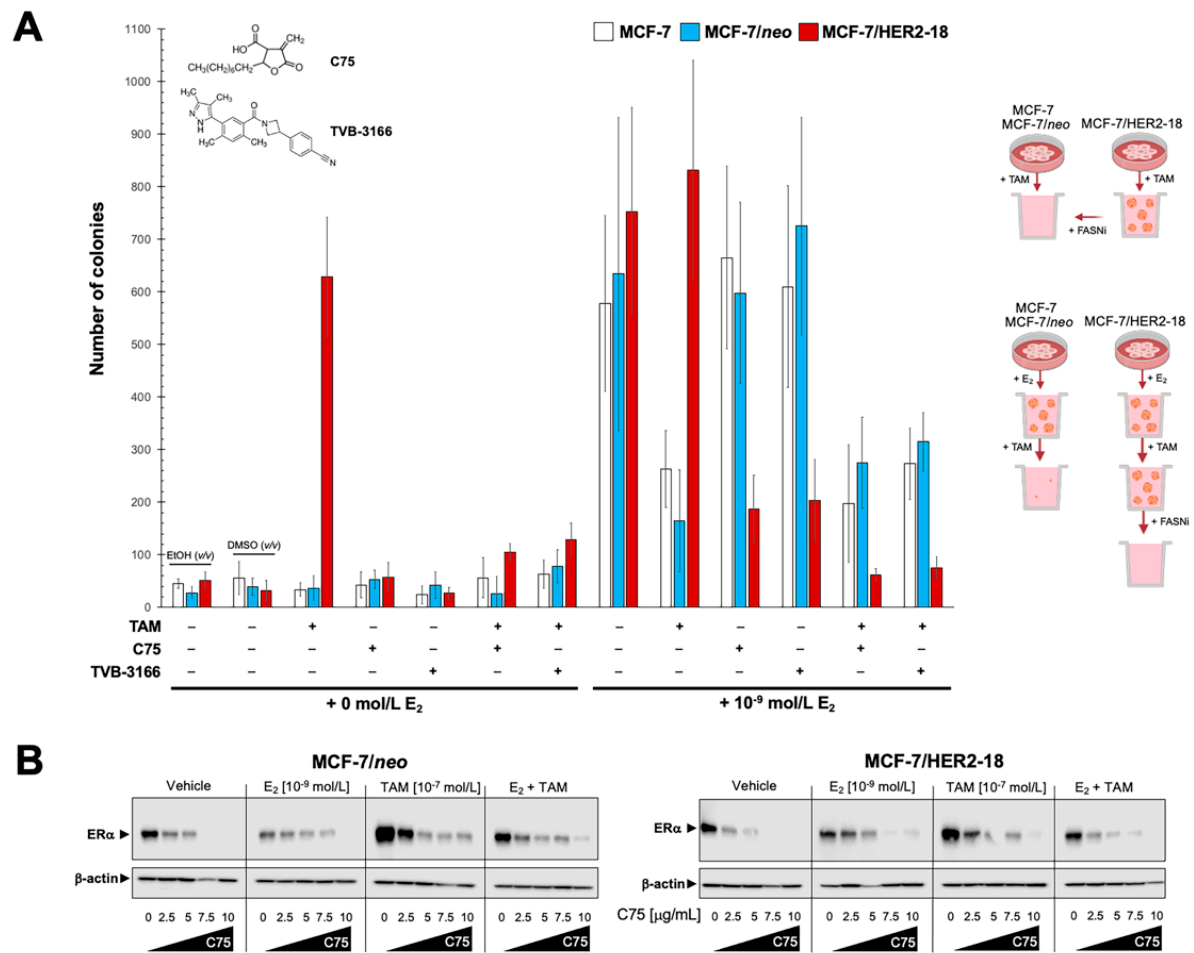
Figure 3. Pharmacological inhibition of FASN activity impedes the tamoxifen-driven cell growth of ER+/HER2+ breast cancer cells. ( A ) Estradiol (E 2 )-depleted cells were plated in soft agarose containing E 2 (10 − 9 mol/L), tamoxifen (10 − 7 mol/L), C75 (7.6 µ g/mL), TVB-3166 (100 nmol/L), their combinations, or ethanol ( v/v ) or DMSO ( v/v ) vehicle only for 15 days. Colony formation ( ≥ 50 µ m) was assessed using a colony counter. Each experimental value represents the mean colony number (columns) ± S.D. (bars) from three separate experiments in which triplicate dishes were counted. (* p < 0.05; ** p < 0.005; n.s. not statistically significant. ( B ) Immunoblot analyses of ER α in MCF-7/neo and MCF-7/HER2-18 cells cultured in the absence or presence of E 2 (10 − 9 mol/L), tamoxifen (10 − 7 mol/L), E 2 plus tamoxifen, and/or graded concentrations of C75 were carried out, as described in “Materials and methods” using an anti-ER α rabbit polyclonal antibody. Blots were reprobed with an anti- β -actin goat polyclonal antibody to control for protein loading and transfer. Figure shows a representative immunoblot analysis. Similar results were obtained in three independent experiments.